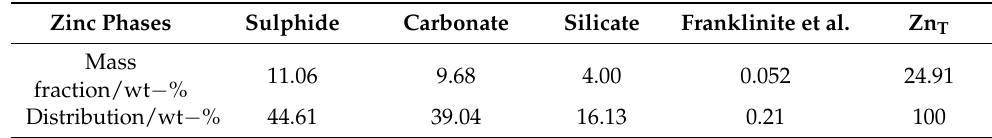
Table 2. The distribution of zinc phases in complex zinc